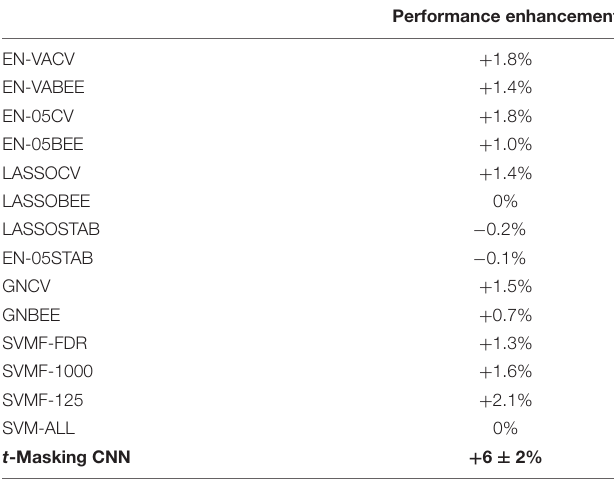
TABLE 2 | Comparison of PE for models using FS techniques, analyzed in Tohka et al. (2016).